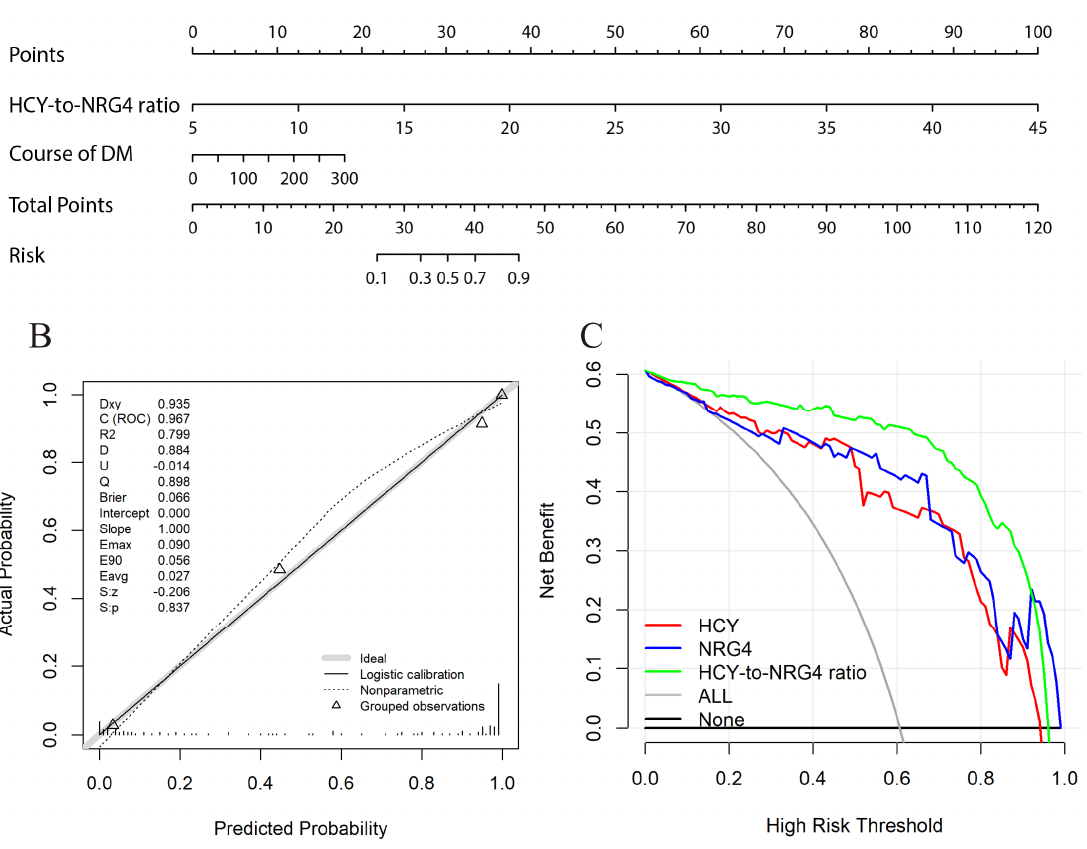
Figure 2. Evaluation of DKD rates associated nomograms, the calibration curves and decision curve analysis for patients with DM. ( A ) The nomogram integrating the HCY/NRG4 and course of DM for predicting the risk of DKD; ( B ) The calibration curve for predicting patients’ risk of DKD; ( C ) Decision curve analysis of the nomogram for the risk of